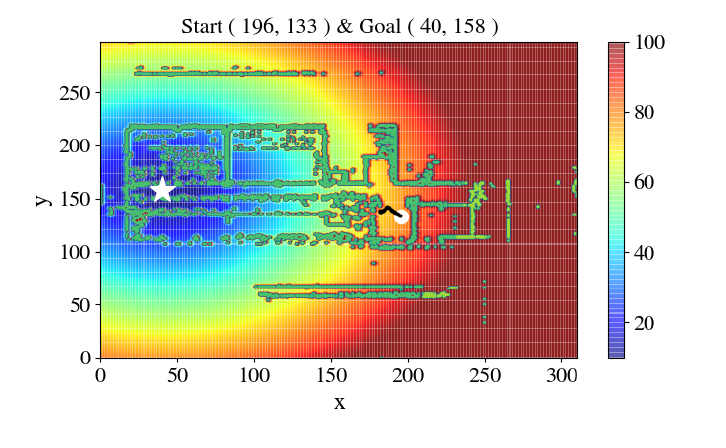
Figure 18. Transformed map—however, search fails.